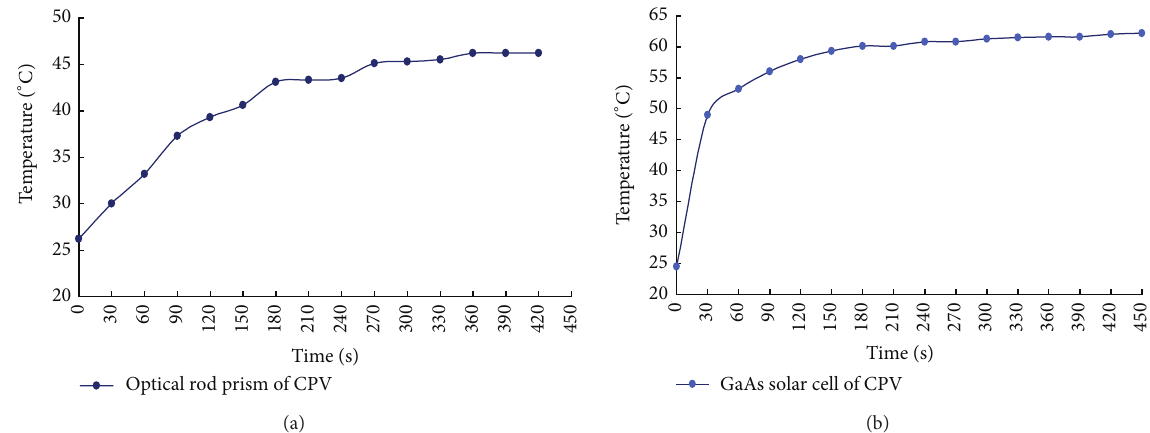
Figure 5: (a) The temperature of the back side of the optical rod prism with time. (b) The temperature of Back side of GaAs solar cell with